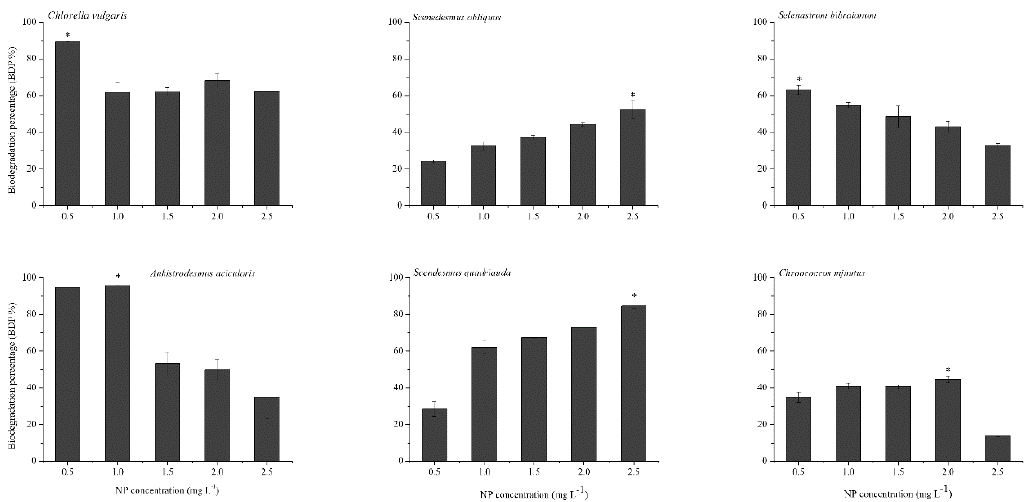
Figure 6. Biodegradation of NP by microalgae. Algae were treated with NP at 0.5–2.5 mg L −1 culture for 120 h. Asterisks indicate the significant differences compared to other NP treatments ( p < 0.05).